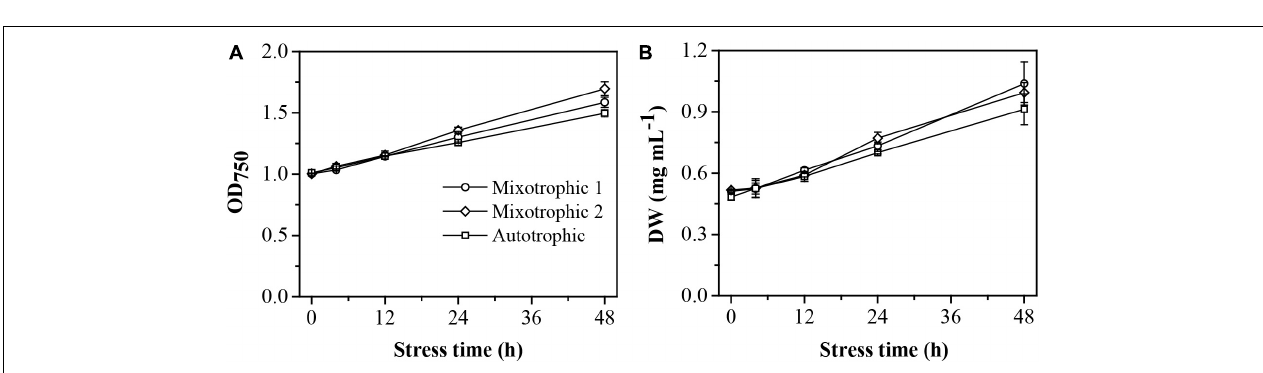
FIGURE 1 | Time course of changes in pH (A) and photosynthetic activity (B) of Chlamydomonas reinhardtii BAFJ5 cultures under three carbon supply regimes over 48 h of HL-N. The carbon supply regimes for mixotrophic 1, mixotrophic 2, and autotrophic were 17 mM acetate and 2% CO 2 (v/v), 17 mM acetate and ambient 0.04% CO 2 (v/v), and 2% CO 2 (v/v), respectively. The pH values of three algal cultures in A were recorded every 10 min, and data were derived from one batch culture. Values in B are the means of three independent replicates ± SD ( n = 3). F v / F m indicates the maximal quantum conversion efficiency.